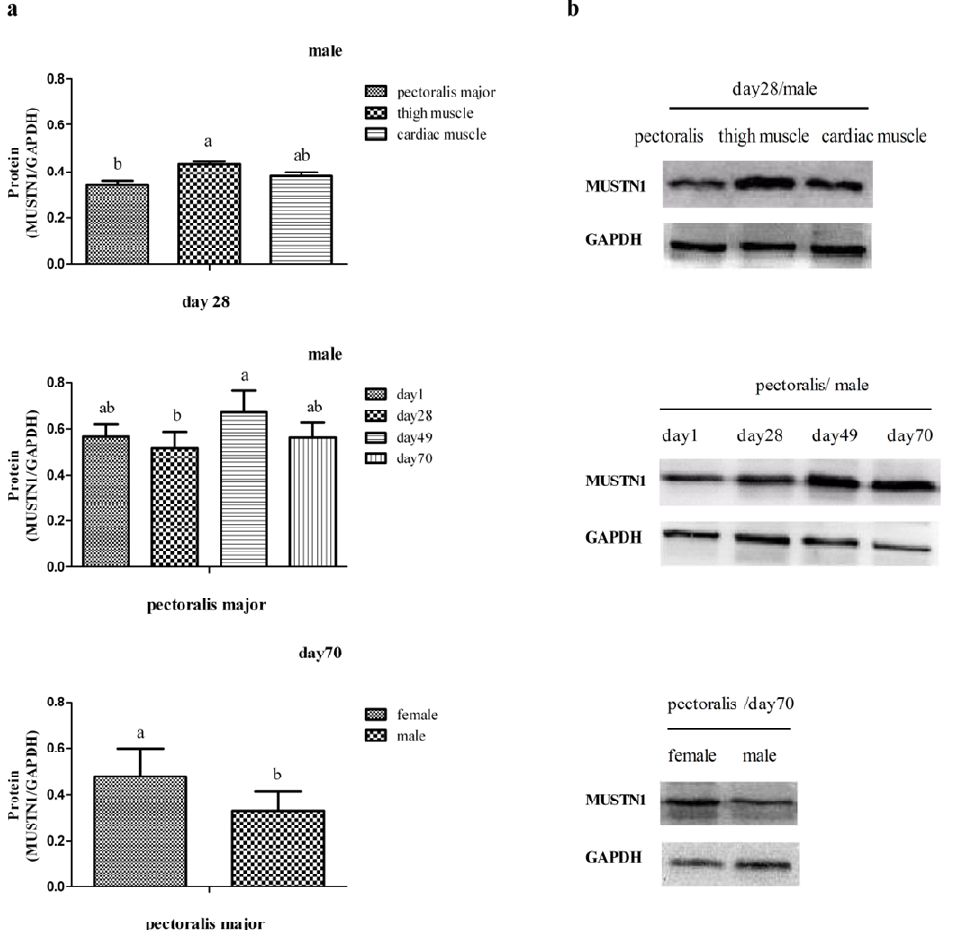
Figure 3. Expression of MUSTN1 protein among muscle tissues at day 28 of male chickens, at days 1, 28, 49 and 70 of male chickens in pectoralis major, and at day 70 of female and male chickens in pectoralis major tissue. ( a ) Protein abundance of MUSTN1; ( b ) Representative western blotting of MUSTN1 and GAPDH. Values are expressed as the ratio of MUSTN1 to GAPDH protein abundance and represent mean ± SD ( n = 4).* denotes p <